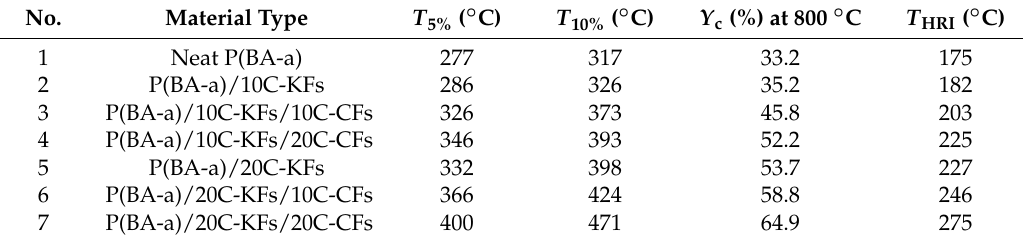
Table 3. Thermal stability parameters of the hybrid composites.